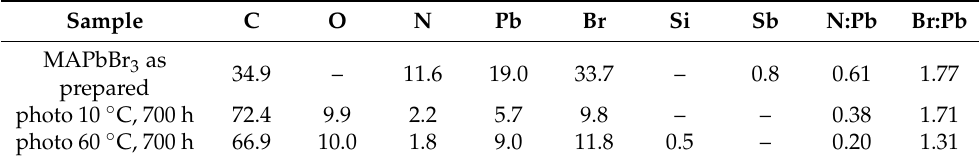
Table 1. Surface composition (in at. %).